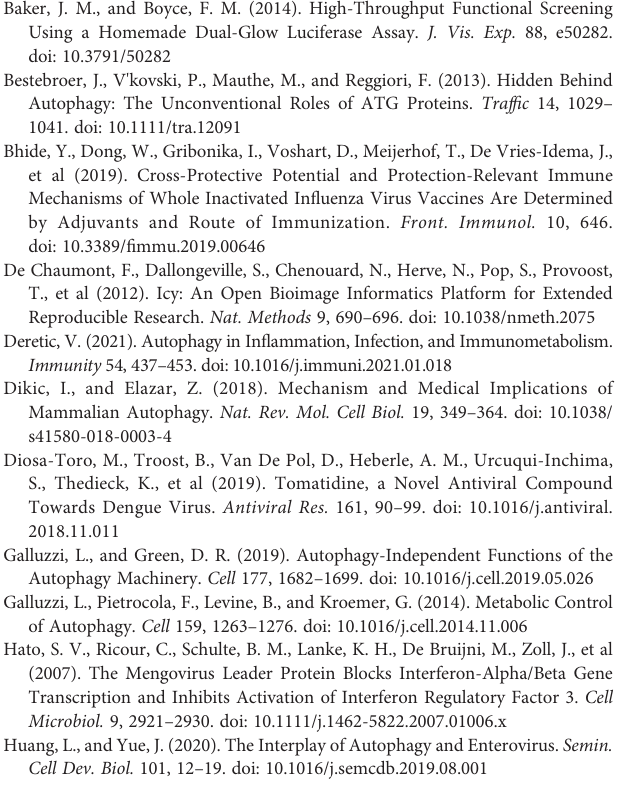
Supplementary Figure 3 | Nuclear translocation of HSBP1 is speci fi cally triggered by picornavirus infection. (A) U2OS cells were transfected with a plasmid carrying